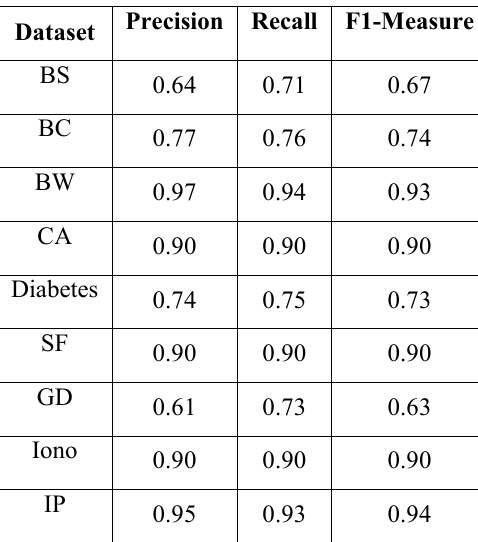
Table 3. Precision, Recall and F-1